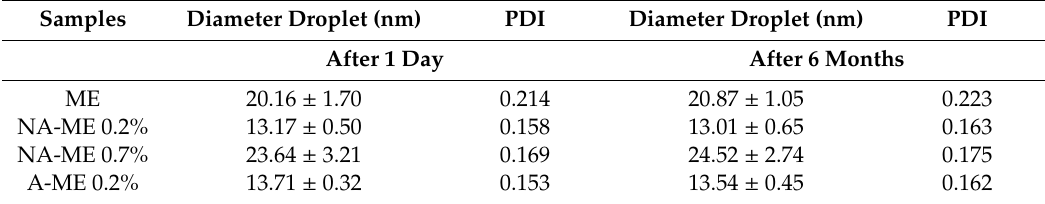
Table 1. Oil droplet size and polydispersity index (PDI) of NA and A in a microemulsions (ME) at di ff erent drug concentrations, after 1 day and 6 months after preparation, at 25 ◦ C. Values are expressed as mean ± S.D. ( n =